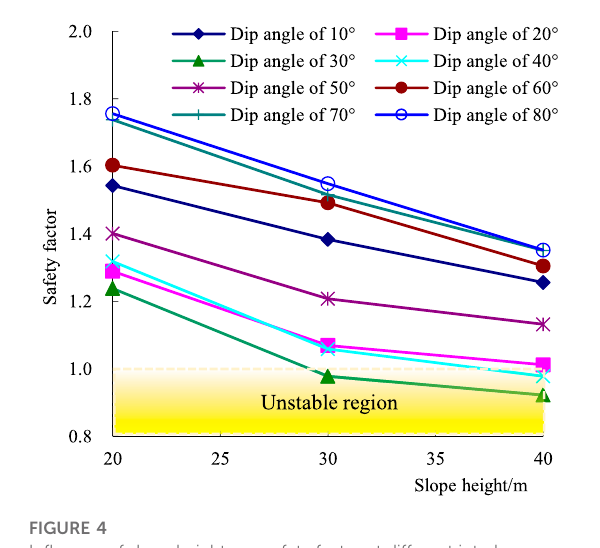
FIGURE 6 In fl uence of interlayer thickness on safety factor at different interlayer